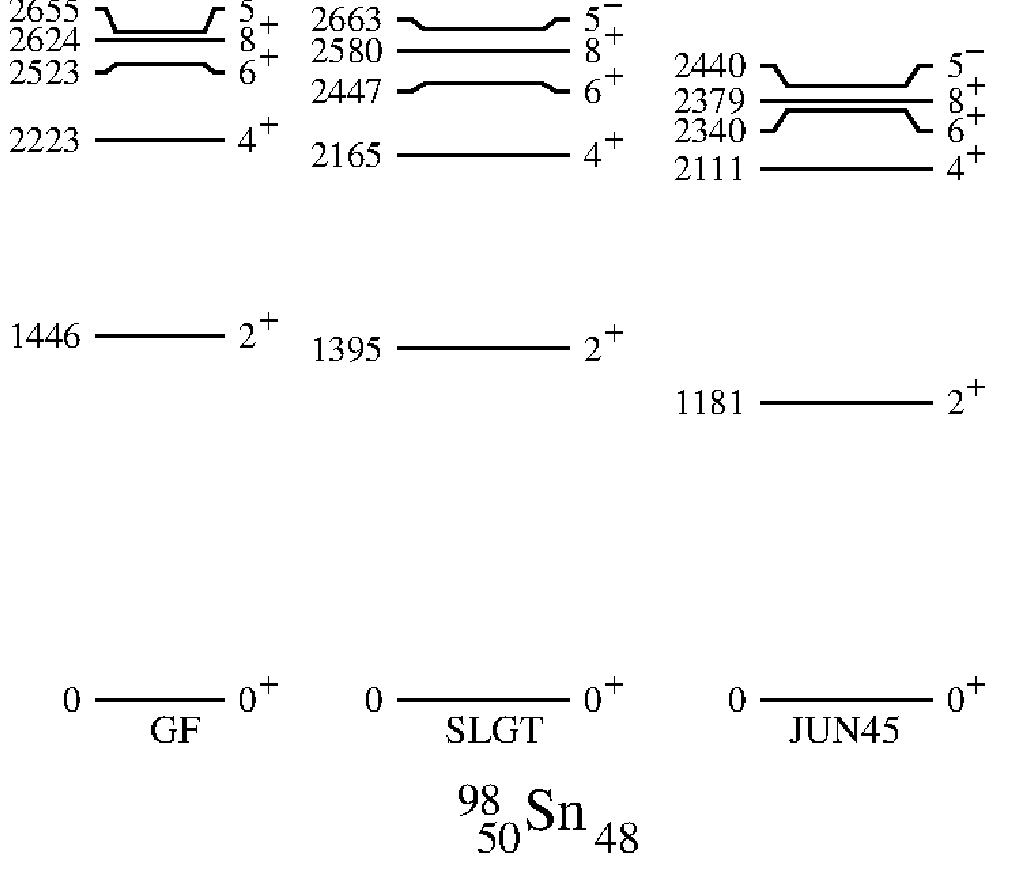
Figure 5. Predictions of the 98 Sn excited states according to the available interactions. All of them suggest an 8 + isomeric state as the one known in the mirror nucleus 98 Cd [149]. The JUN45 spectrum is identical to that one of 98 Cd because of the isospin symmetry of this interaction.